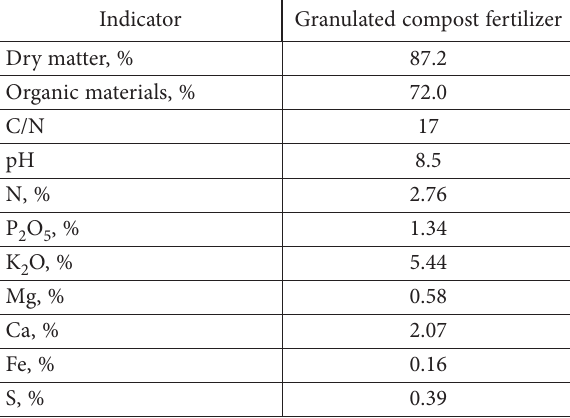
Table 2. Chemical composition of cattle compost granulated fertilizers production of 2014 (IP1) Indicator